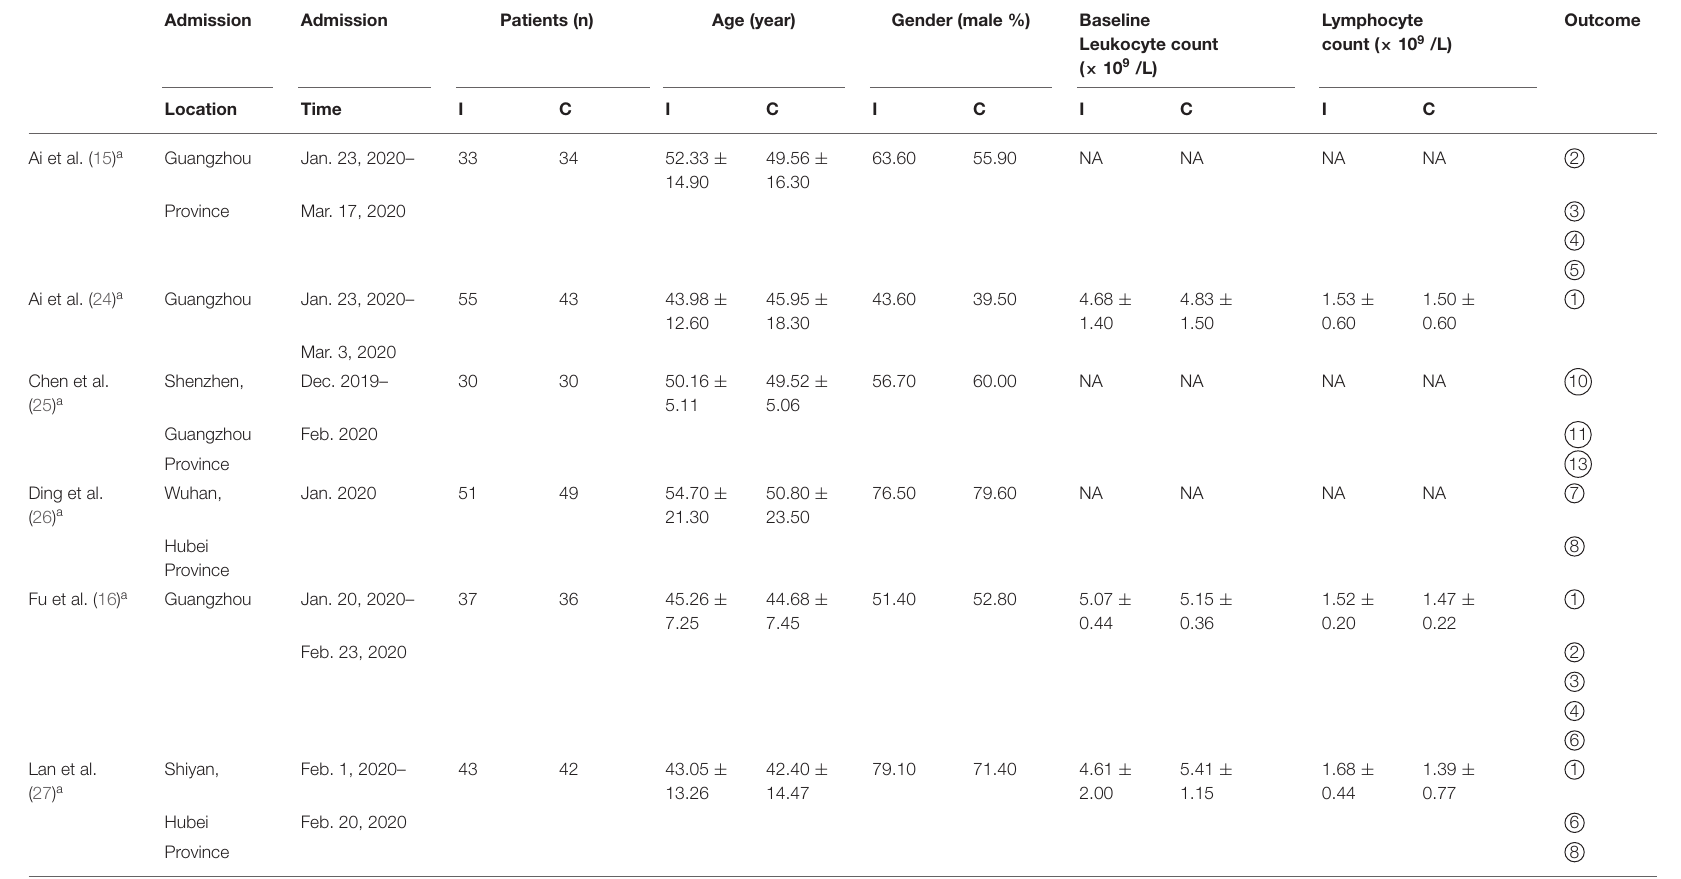
TABLE 2 | Basic characteristics of the observational